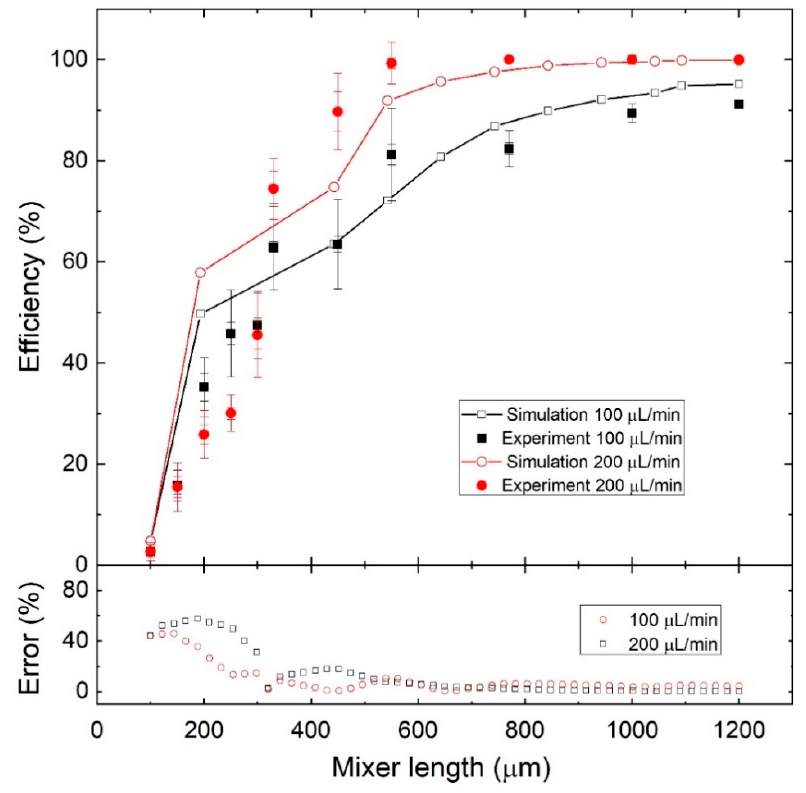
Figure 5. ( a ) Comparison of the simulated and experimental results of the mixing efficiency versus the mixing length along the serpentine mixing channel for two different flow rates: 100 and 200 µL/min; ( b ) the deviation (error) in % between simulated and experimental results.